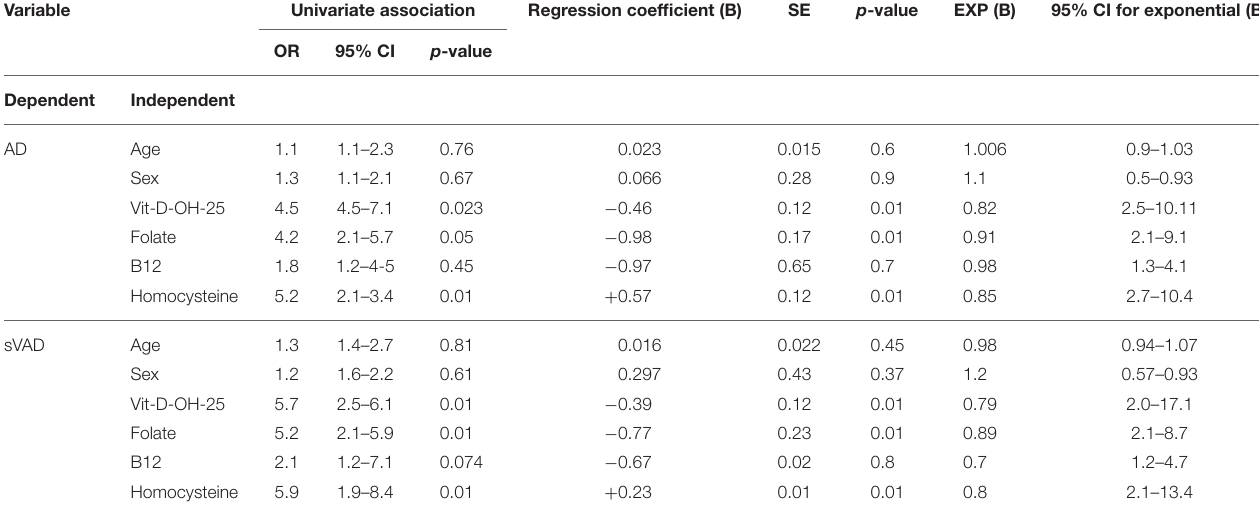
TABLE 5 | Summary of multinomial logistic regression